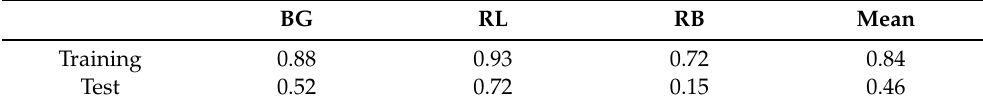
Table 13. IoU scores for Rice blast in Experiment B.